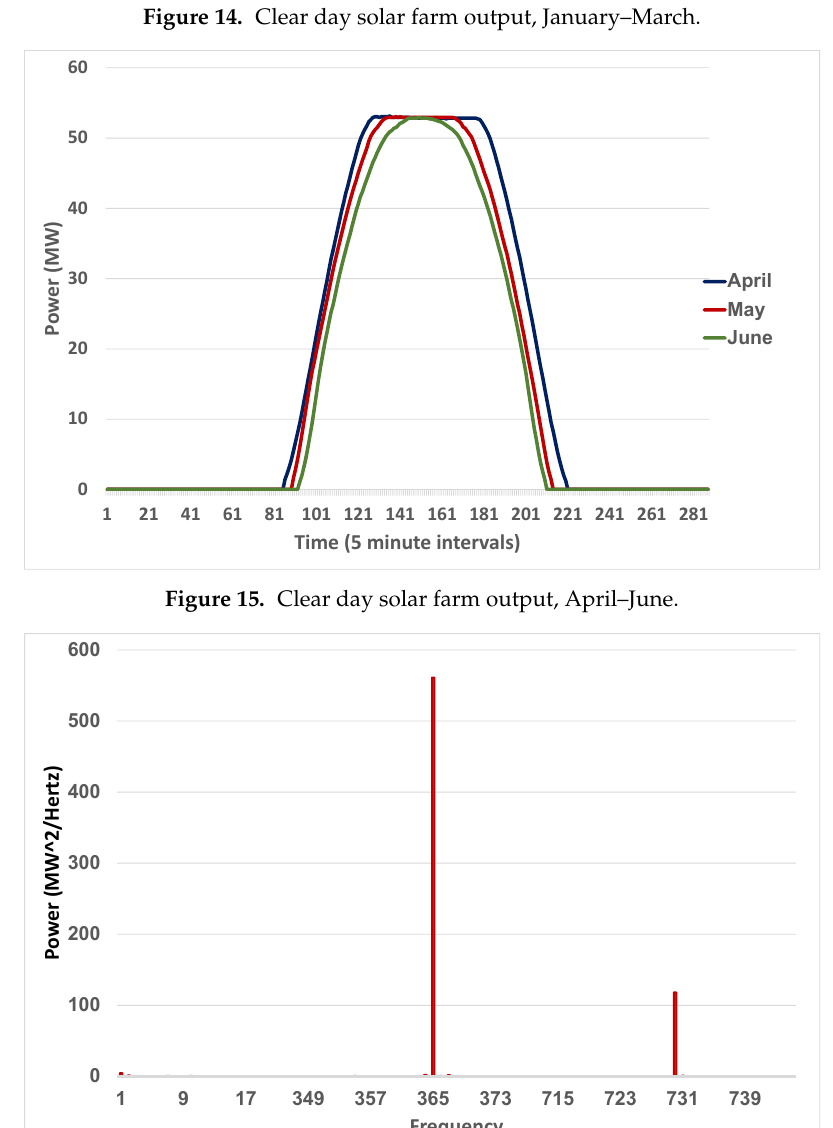
Figure 14. Clear day solar farm output, January–March.